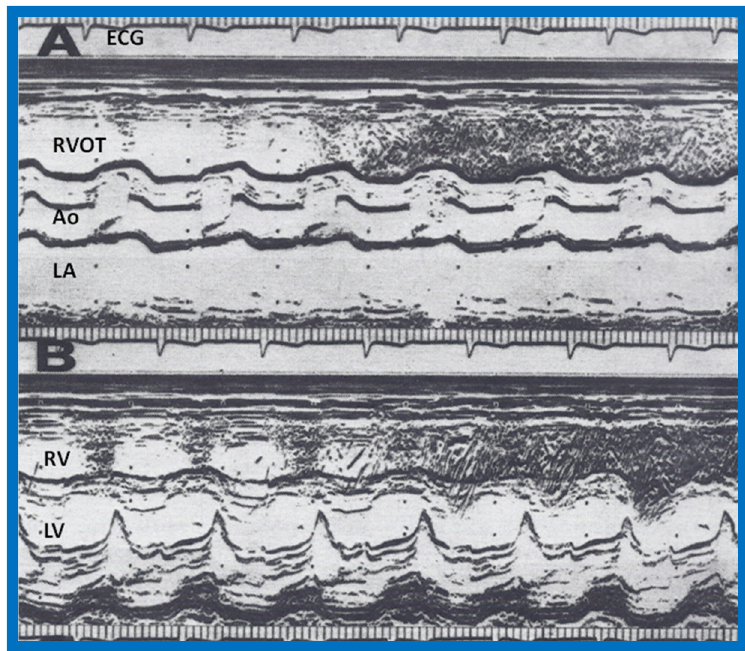
Figure 8. Following surgical correction, recordings similar to Figure 4 were made while injecting agitated saline into the veins of the hand; these revealed contrast in the right ventricular outflow tract (RVOT) ( A ) and right ventricle (RV) ( B ), suggesting that the superior vena cava now drains normally into the right atrium (not shown) and RV. Ao, aorta; ECG, electrocardiogram; LA, left atrium; LV, left ventricle. Modified from Alpert B.S., Rao P.S., et al. [3].